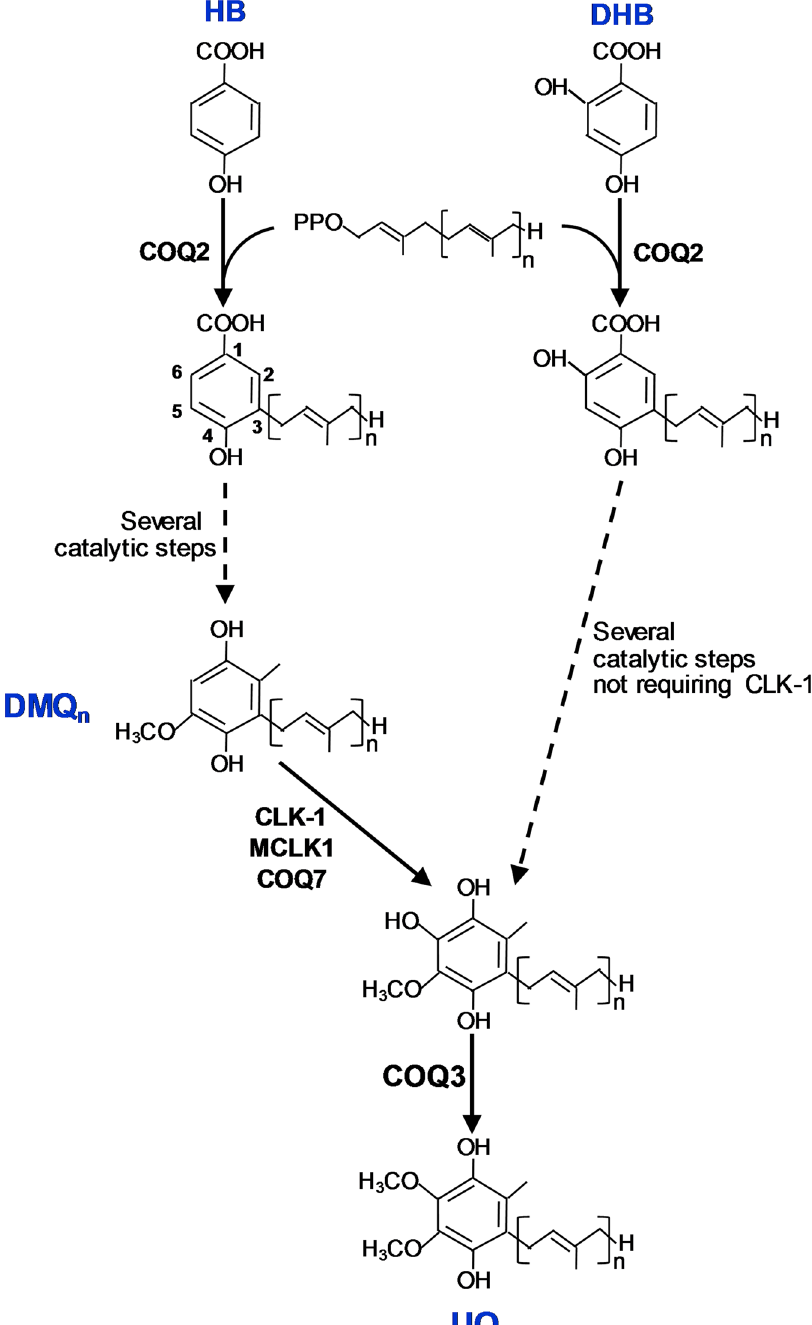
Figure 1. 2,4-dihydroxybenzoate (DHB) is an unnatural bypass precursor of UQ biosynthesis. UQ is composed of a benzoquinone ring attached to a polyisoprenoid side chain. The length of the side chain varies between species. It is 9 isoprenoid subunits long in C . elegans (UQ 9 ). All cells depend on endogenous biosynthesis for their supply of UQ. The enzyme encoded by clk-1 and its orthologues ( Coq7 in yeast, Mclk1 in mice, and COQ7 in humans) catalyzes the penultimate step in UQ biosynthesis, the hydroxylation of DMQ at position 6. In eukaryotes, the natural biosynthetic precursor for the benzoquinone ring is 4-hydroxybenzoate (4-HB), but 2,4-dihydroxybenzoate (DHB), a hydroxylated analogue of 4-HB, is able to serve as an alternative, albeit unnatural, precursor of UQ synthesis that allows for the biosynthesis of UQ in the absence of CLK-1/COQ7/ MCLK1 step 23, 24